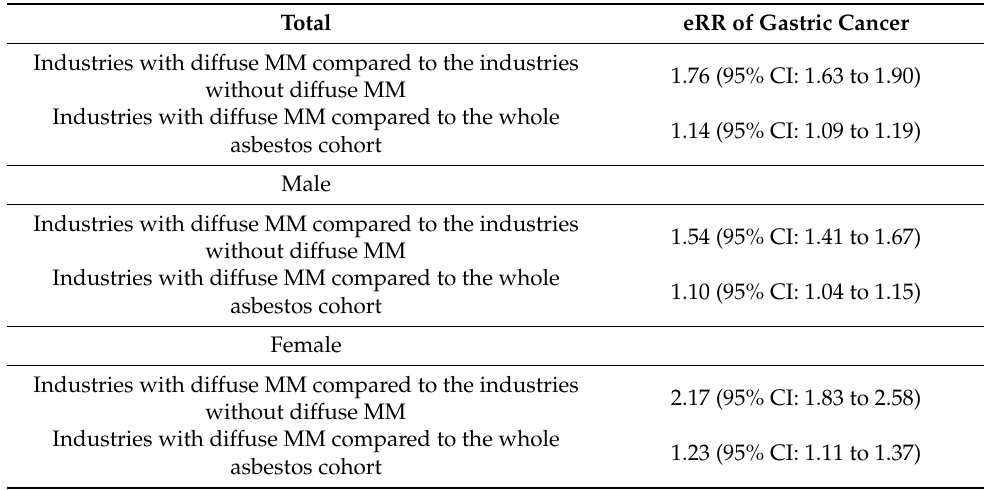
Table 2. Estimated rate ratio (eRR) of gastric cancer among asbestos-exposed workers in industries with diffuse malignant mesothelioma